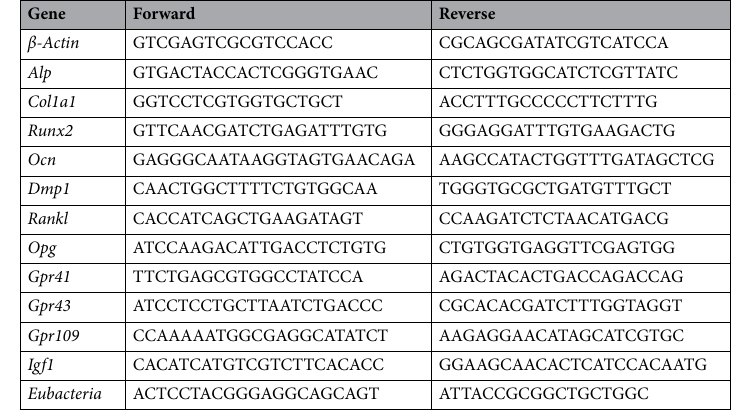
Table 1. Primers used for RT-qPCR.